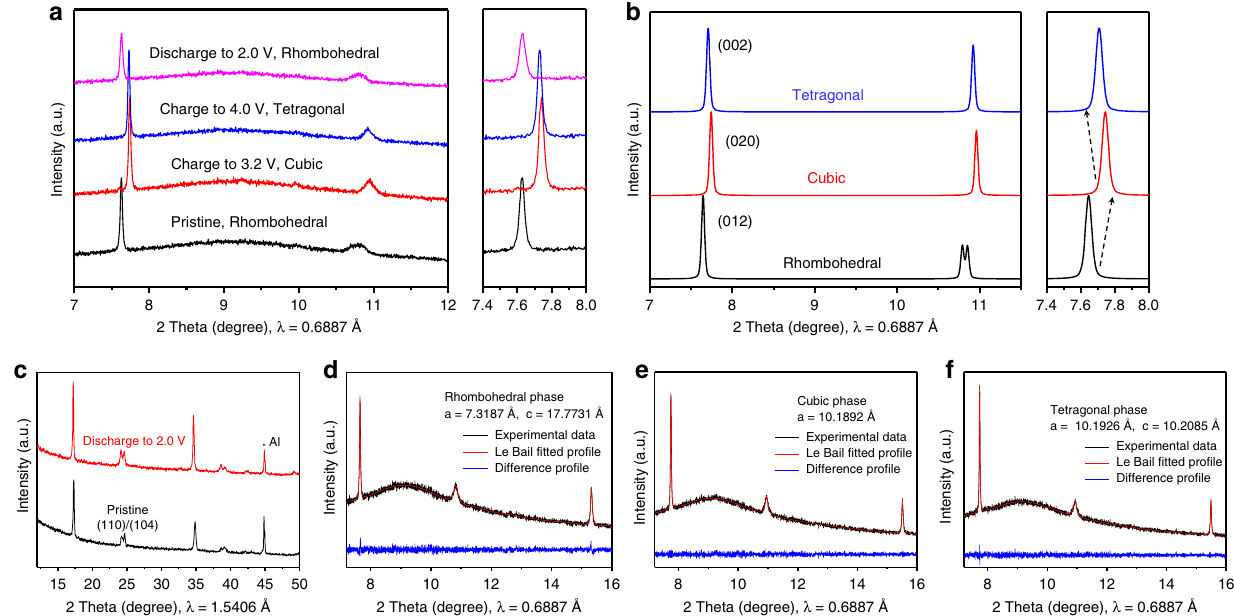
Fig. 5 Structural characterization of PB-S3 sample during cycling. a Synchrotron PXRD patterns of PB-S3 sample at different voltages, ( b ) simulated PXRD patterns of three different phases, ( c ) PXRD patterns of electrode of pristine and 2.0 V discharing state, ( d – f ) Le Bail fi tted PXRD patterns from pristine PB-S3 (rhombohedral), 3.2 V charging (cubic), and 4.0 V charing states (tetragonal). three-phase transitions for rhombohedral Na 2 − x FeFe(CN) 6 were contributes majority of the capacity with stable high spin Fe 2 + redox reaction, and the cubic to the tetragonal phase transition observed for the fi rst time. Moreover, the phase transitions for could account for the extra charge capacity more than that of cubic rhombohedral structure is consistent with the charge – discharge phase with insuf fi cient sodium content. The highly reversible phase curve of PB-S3 as well (Fig. 3a). The rhombohedral to cubic transitions for rhombohedral structure of PB-S3 could also explain structure corresponds to the long plateau below 3.2 V, which NATURE COMMUNICATIONS| (2020) 11:980